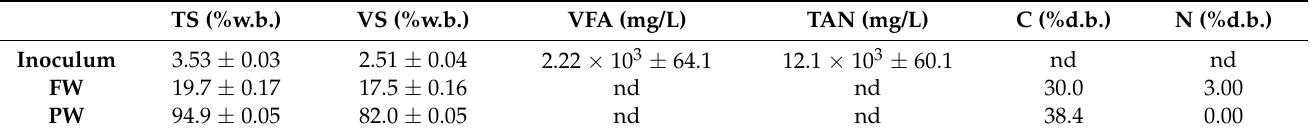
Table 1. Characteristics of the raw materials used in the study (FW = food waste, PW = paper waste, TS = total solid content, VS = volatile solid content, VFA = volatile fatty acid content, TAN = total ammonia nitrogen content, FA= free ammonia, C = carbon content, N = nitrogen content, w.b. = wet basis, d.b. = dry basis, nd = not determined).